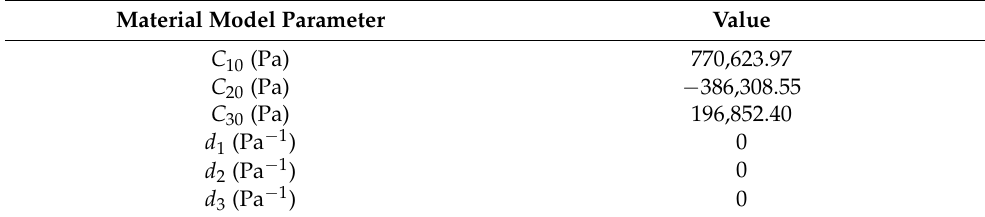
Table 8. Material parameter set for the hyperelastic material of the silicone.